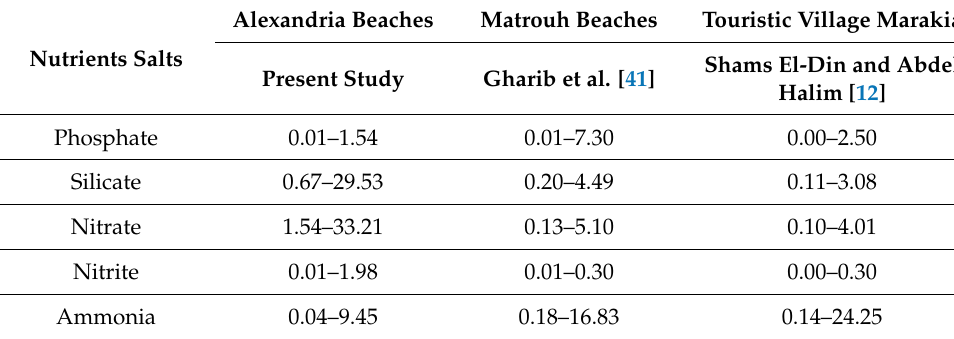
Table 5. Several year observations of nutrient salts ( µ g L − 1 ) in Alexandria